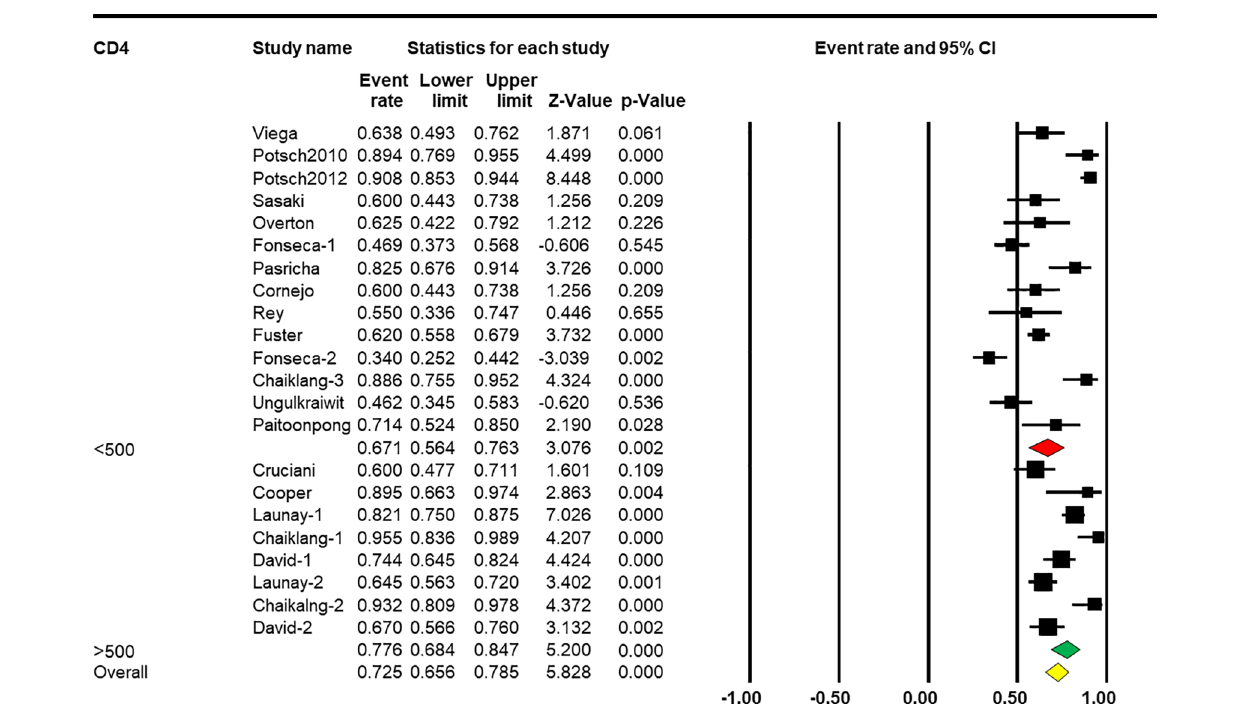
FIGURE 6 | Ef fi cacy of HBV vaccination with different CD4 strati fi cation (<500 vs. ≥ 500 cells/mm 3 ) on the response